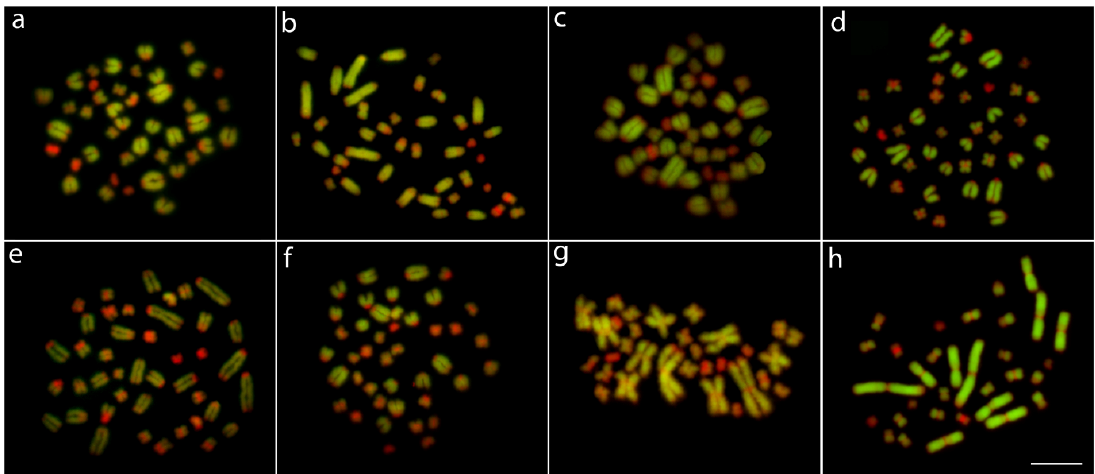
Figure 4. Metaphase chromosomes from females of Caiman crocodilus ( a ), C. latirostris ( b ), C. yacare ( c ), Melanosuchus niger ( d ), Paleosuchus palpebrosus ( e ), P. trigonatus ( f ), Alligator mississippiensis ( g ), and A. sinensis ( h ) after CMA3/DAPI banding (GC- and AT-rich regions pseudocolored in red and green, respectively). Bar = 20 µm.